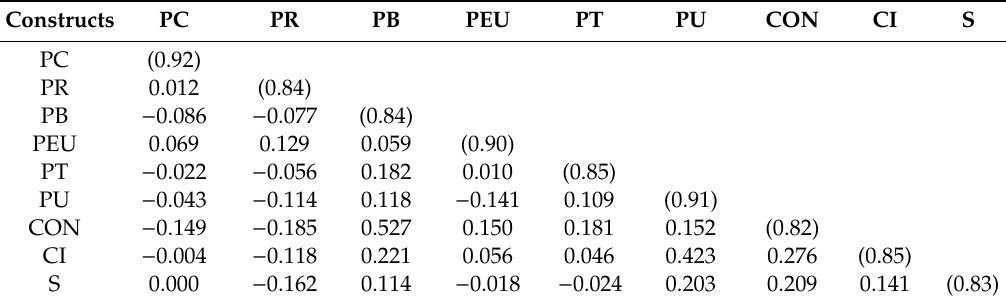
Table 3. Results of the Fornell–Larcker validation.